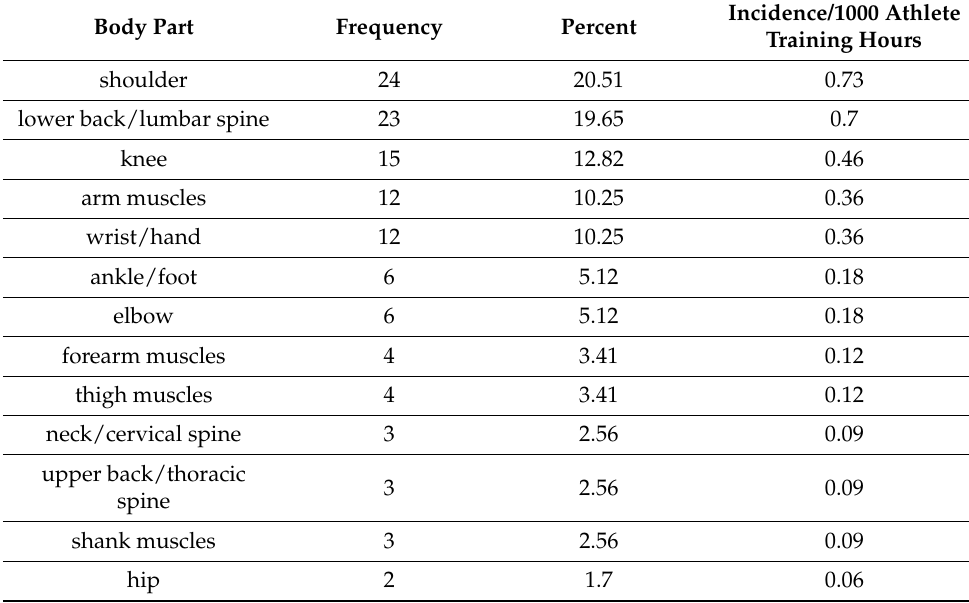
Table 4. Frequency, percentage, and incidence rate of injured body